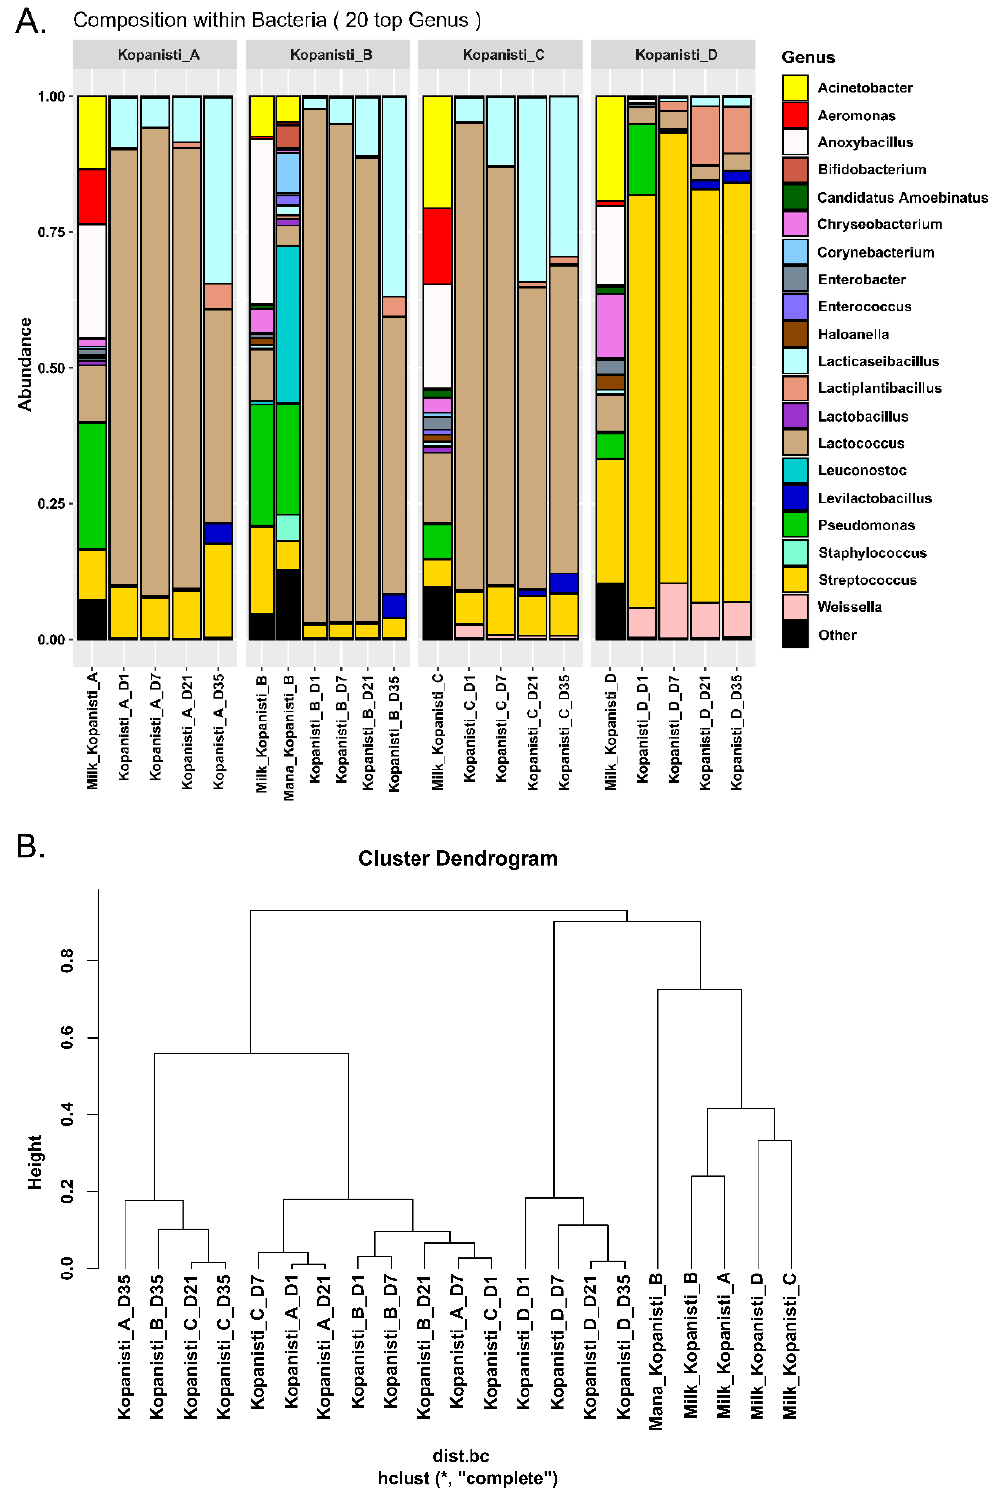
Figure 3. Composition plots of the relative abundances of the 20 most abundant bacteria zOTUs taxonomically assigned at the genus level in pasteurized milk, Mana Kopanisti and Kopanisti cheese samples. Samples from each Kopanisti type (A–D) are presented together in subpanels ( A ). Hierarchical clustering of the bacteria communities at the genus level identified in pasteurized milk, Mana Kopanisti and Kopanisti cheese samples ( B ).